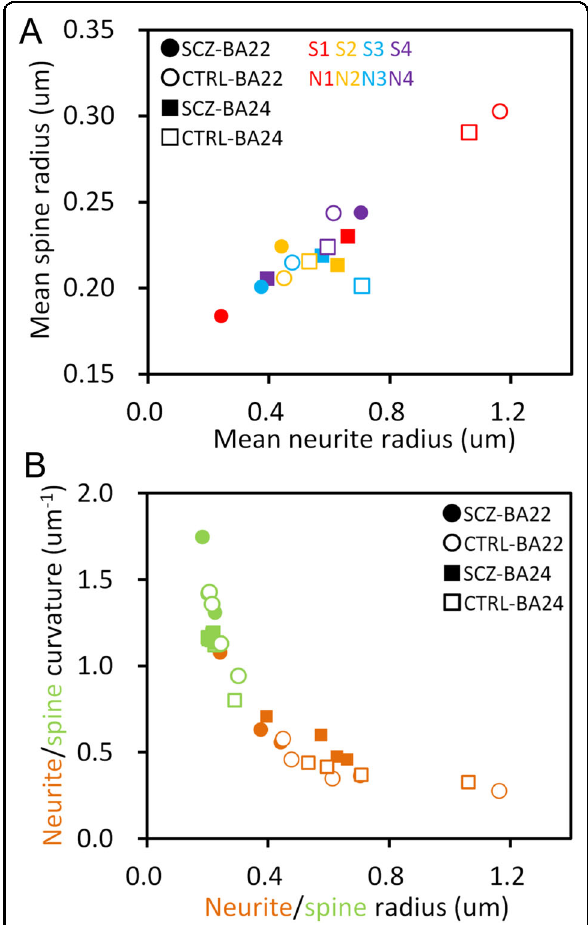
Fig. 3 Common structural features of neurons. A Linear correlation between mean thickness radii of neurites and spines. Arithmetic mean of neurite radii or spine radii was calculated for BA22 or BA24 of each case. Schizophrenia cases S1 – S4 and controls N1 – N4 are color-coded. B Reciprocal relationship between curvature and thickness radius. Arithmetic mean of curvature or radius of neurites (orange) or spines (green) was calculated for BA22 or BA24 of each